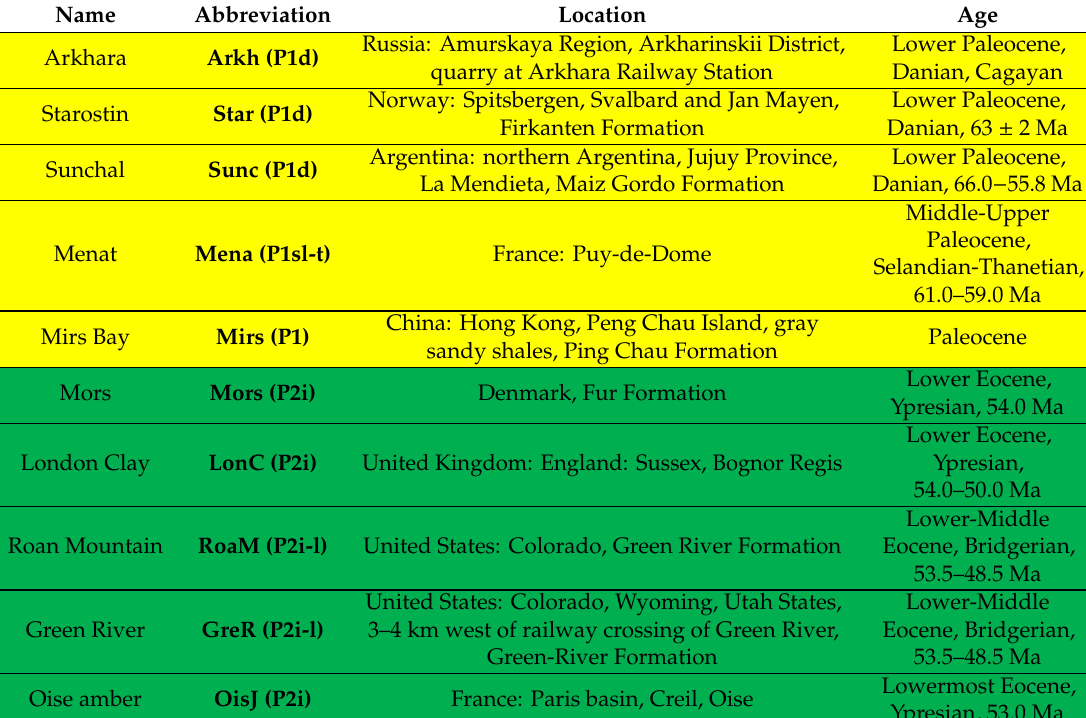
Figure 7. Composition of species of Curculionoidea in the Early Eocene fauna.